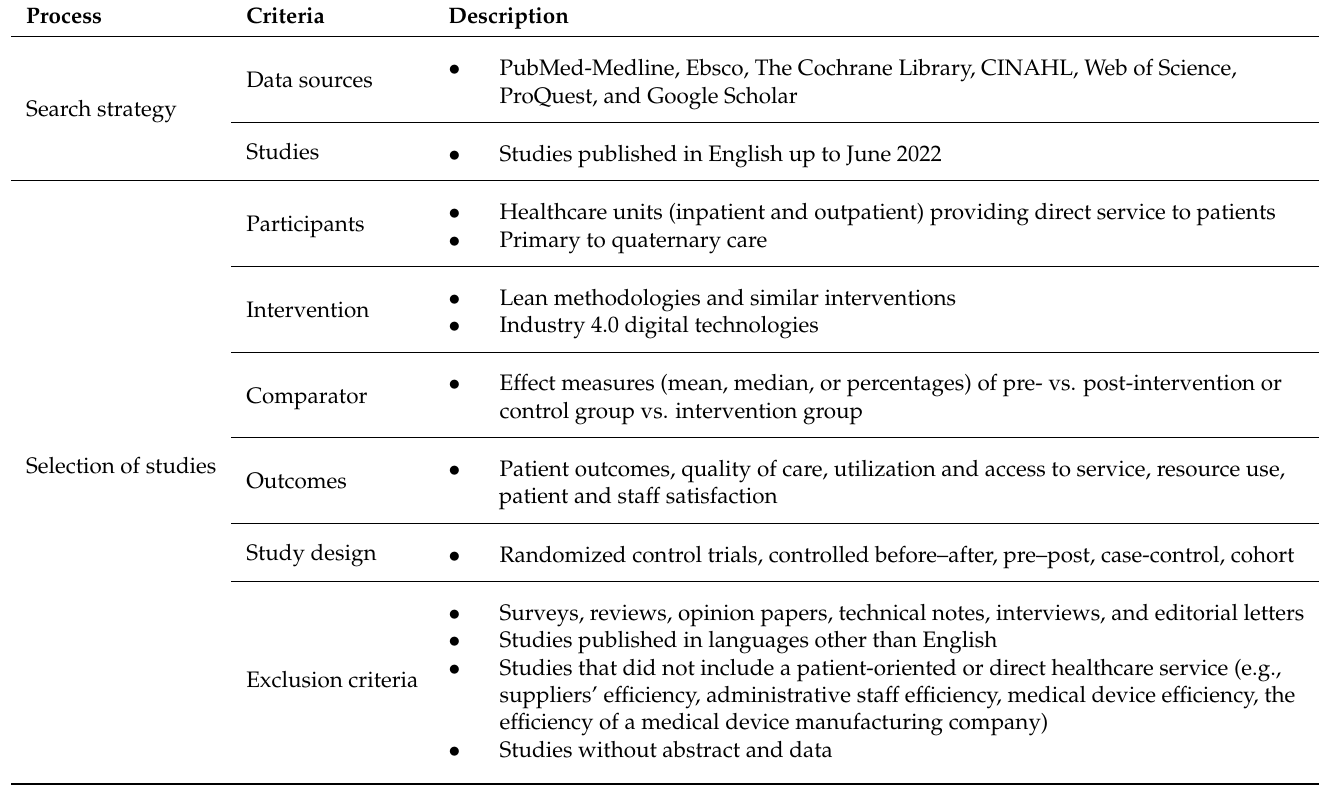
Table 1. Systematic review